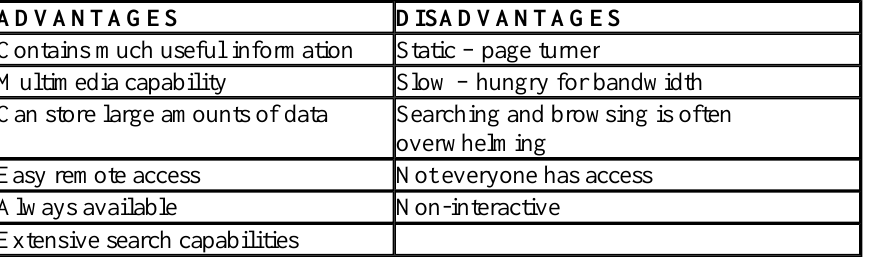
Table 4 Advantages and disadvantages of Web